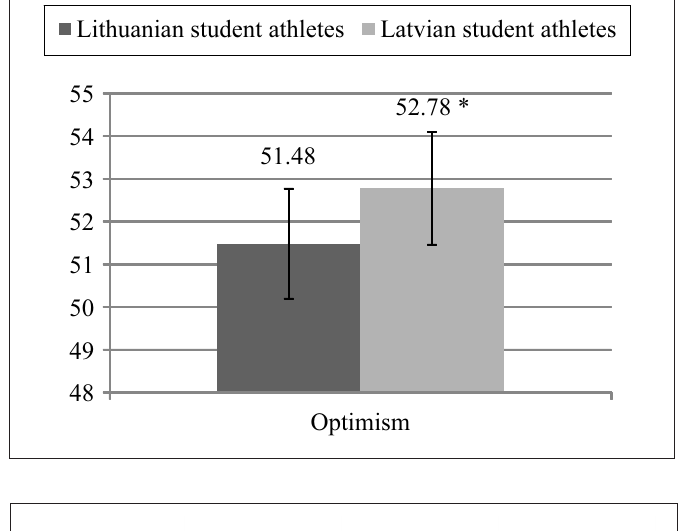
Note. * – p < .05 – there is a statistically significant difference between the results of Lithuanian and Latvian student athletes. Figure 2. Mean scores of the ability of the Lithuanian athletes. and Latvian student athletes to understand and analyse emotions (social skills) Figure 1. Mean scores of the ability of the Lithuanian and Latvian student athletes to use personal positive emotional experience (optimism)